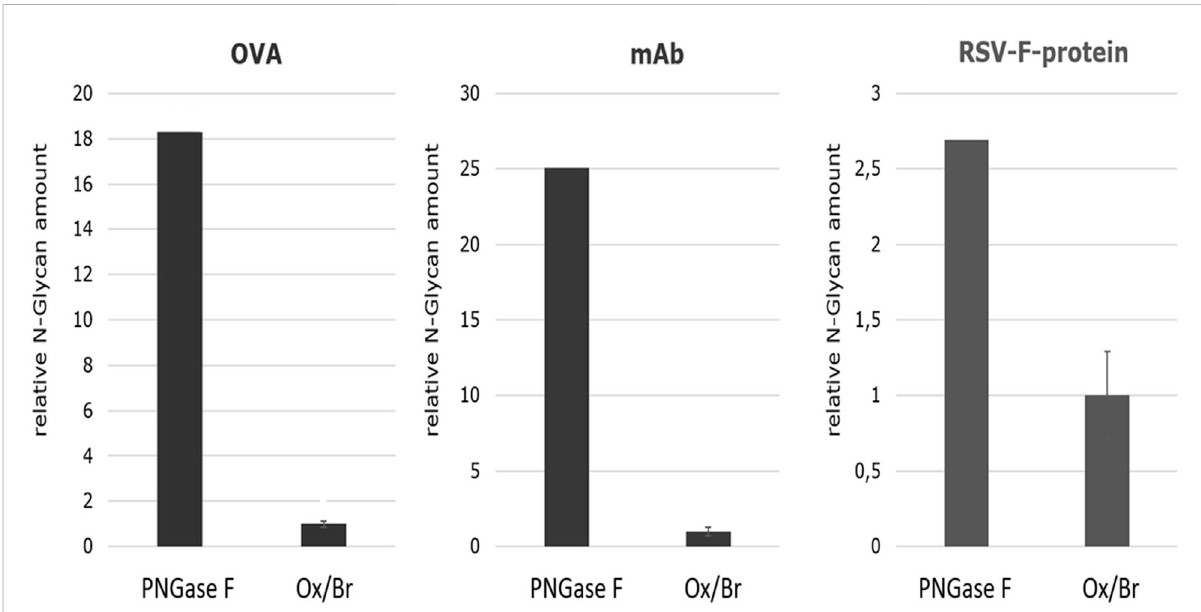
FIGURE 9 ComparisonoftheN-glycanreleaseef fi ciencybetweentheOxone ® /BromideandPNGaseFmethodforthreedifferentglycoproteins basedon therelativeN-glycanamount.ThecumulativepeakareaofallN-glycanpeaksobtainedbyeithertheOxone ® /BromideorbyPNGaseFtreatmentwas obtainedforeachofthethreedifferentglycoproteins — chickenovalbumin,IgG1-monoclonalantibodyandRSVF.TherelativeN-glycanamountwas determined by the sum of the peak area of the major N-glycan form of the respective glycoproteins. For the KBr/Ox method, the mean value including standard deviation ( n = 3) was determined, the value normalized to 1, and plotted relative to PNGase F. Shown on the left is the relative N-glycan amount of ovalbumin (OVA) (sum of peak area of 10 glycan peaks), in the middle of IgG1-monoclonal antibody (mAb) (sum of peak area of G0F, G1F, G2F) and on the right of RSVF protein (peak area of Core-F) of the two release methods.